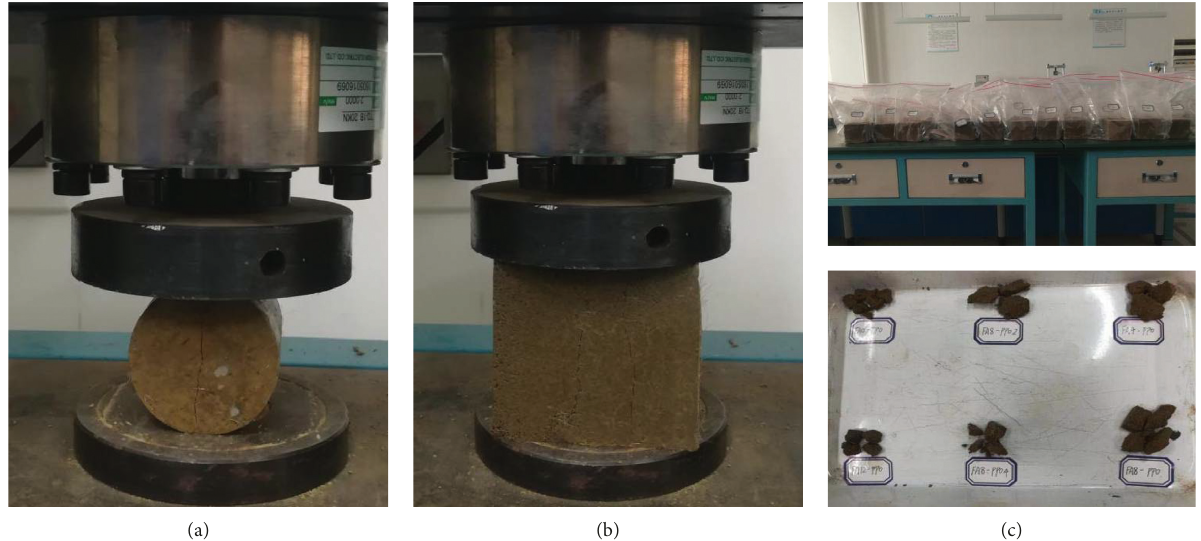
Figure 3: Preparation of soil-cement for unconfined compression test, splitting tension test, and SEM test. (a) Splitting tension test. (b) Unconfined compression test. (c) The prepared samples.